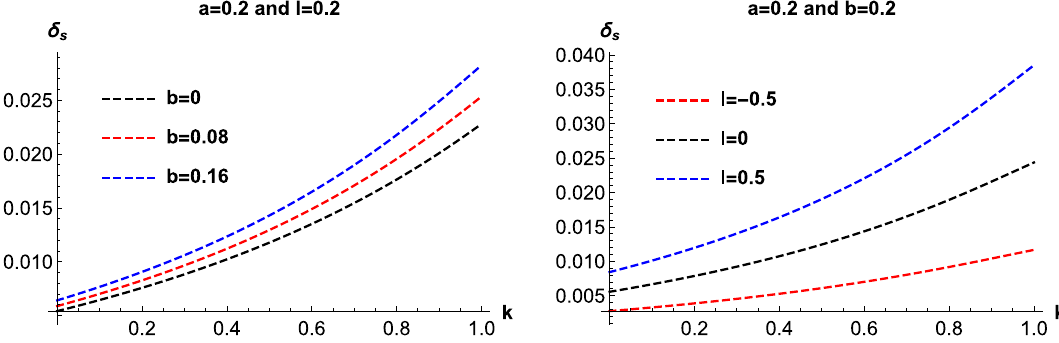
Fig. 14 The figure at the left side represents the variation of deviation from circularity δ s with k for different values of b with a = 0 . 2 and l = 0 . 2. The figure at the right side represents the variation of δ s with k for different values of l with a = 0 . 2 and b = 0 . 2